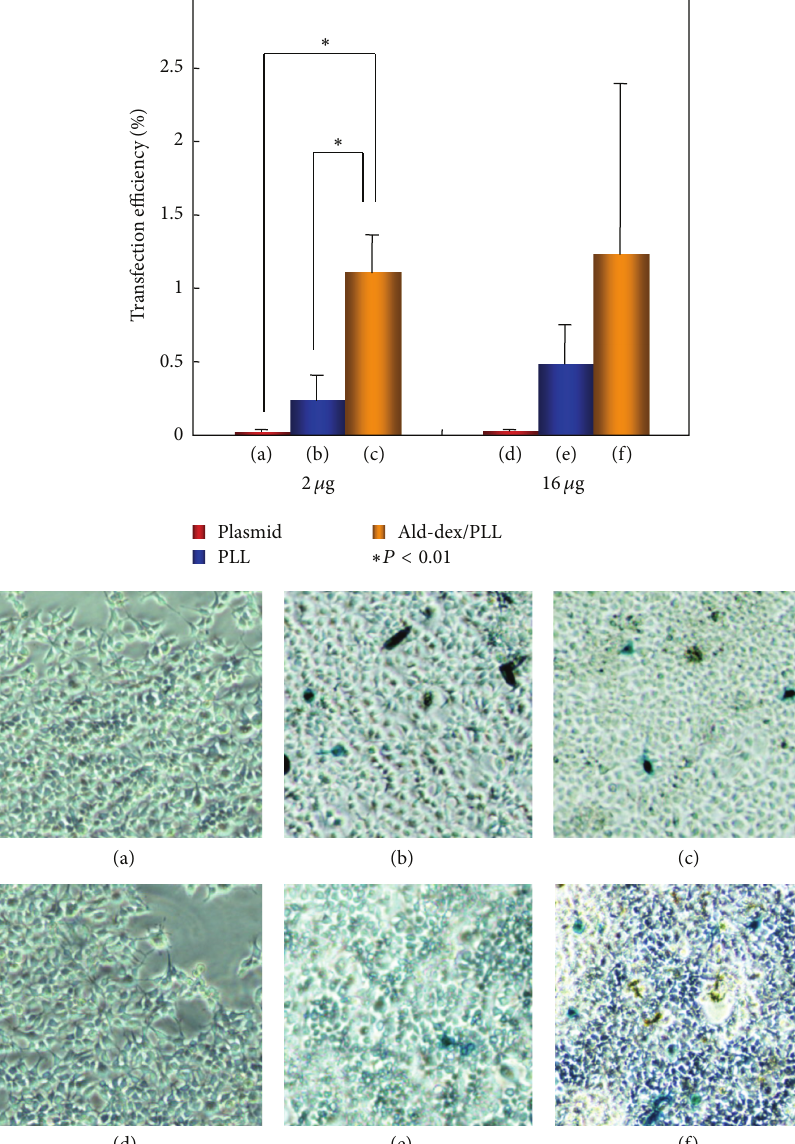
Figure 2: Gene transfection into 293 cells. (a), (b), and (c): results of gene transfection in plasmid of 2 𝜇 g. (d), (e), and (f): results of gene transfection in plasmid of 16 𝜇 g. (a) and (d) were carried out by only plasmid, and (b) and (e) were carried out by using PLL as a gene